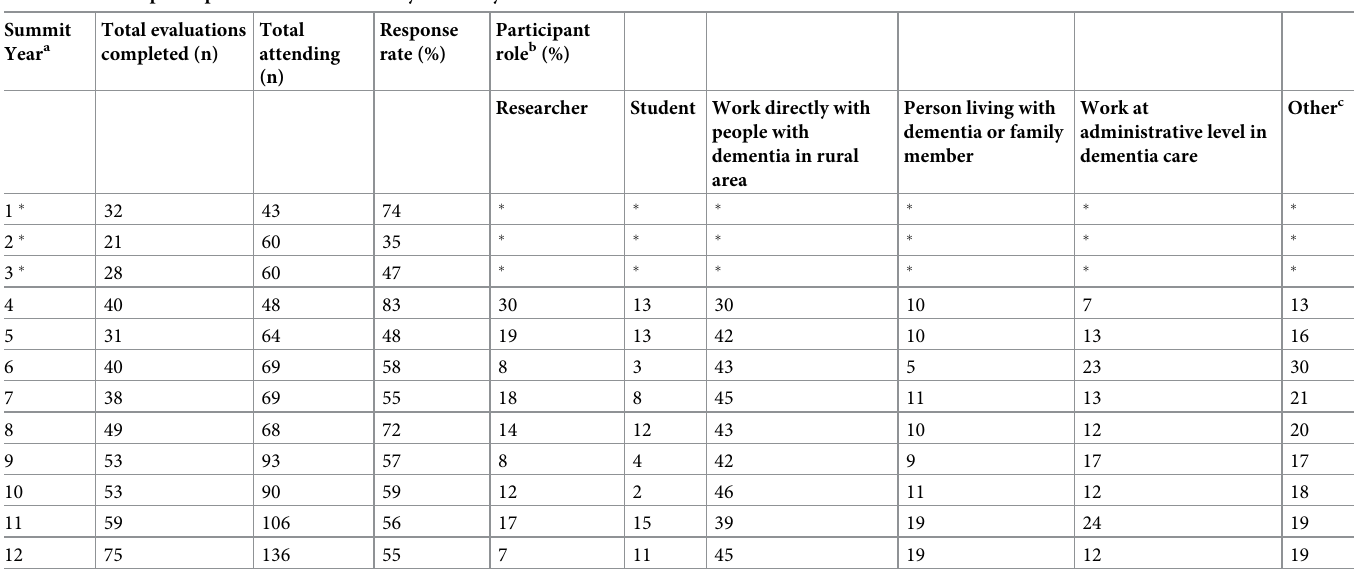
Table 2. Summit participant numbers and role by Summit